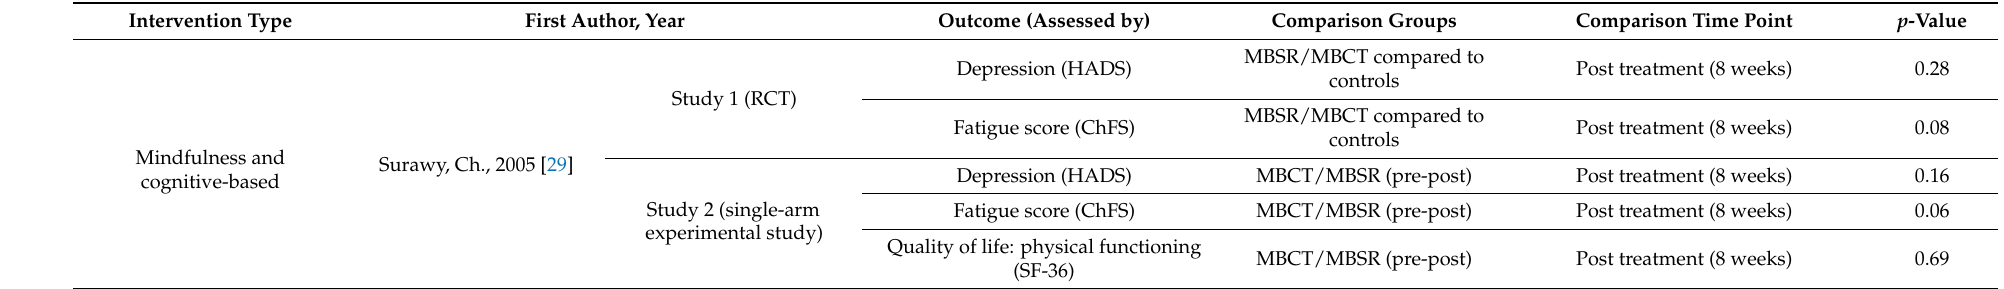
Table A4. Statistically insignificant outcomes in the included studies using Oxford criteria for diagnosing